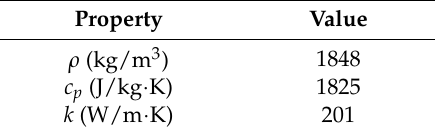
Table 3. Beryllium properties.